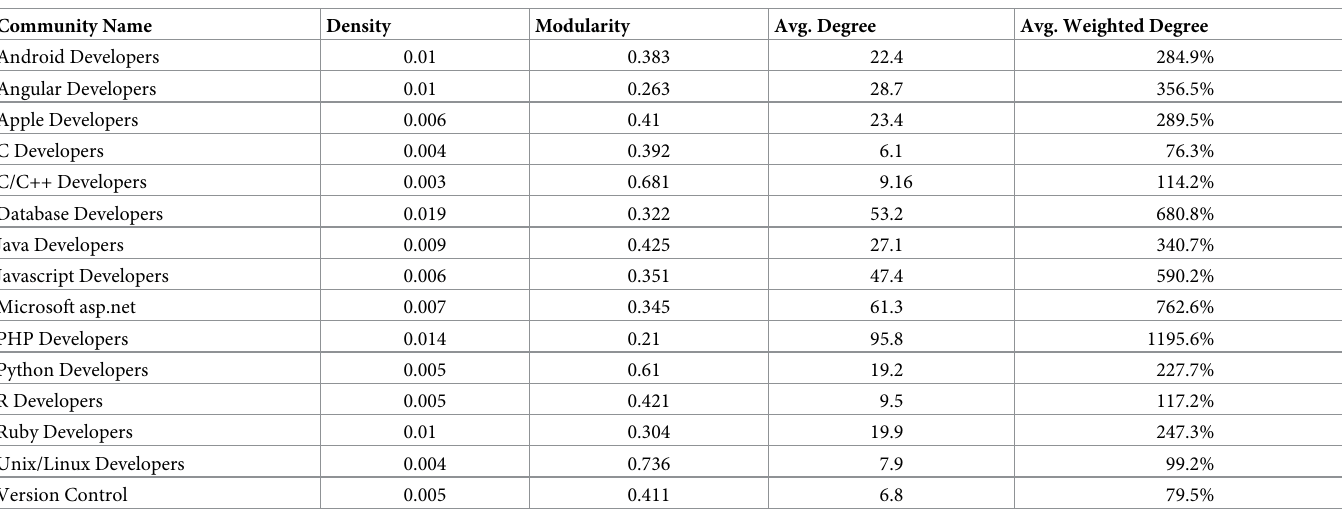
Table 2. Network metrics of the detected